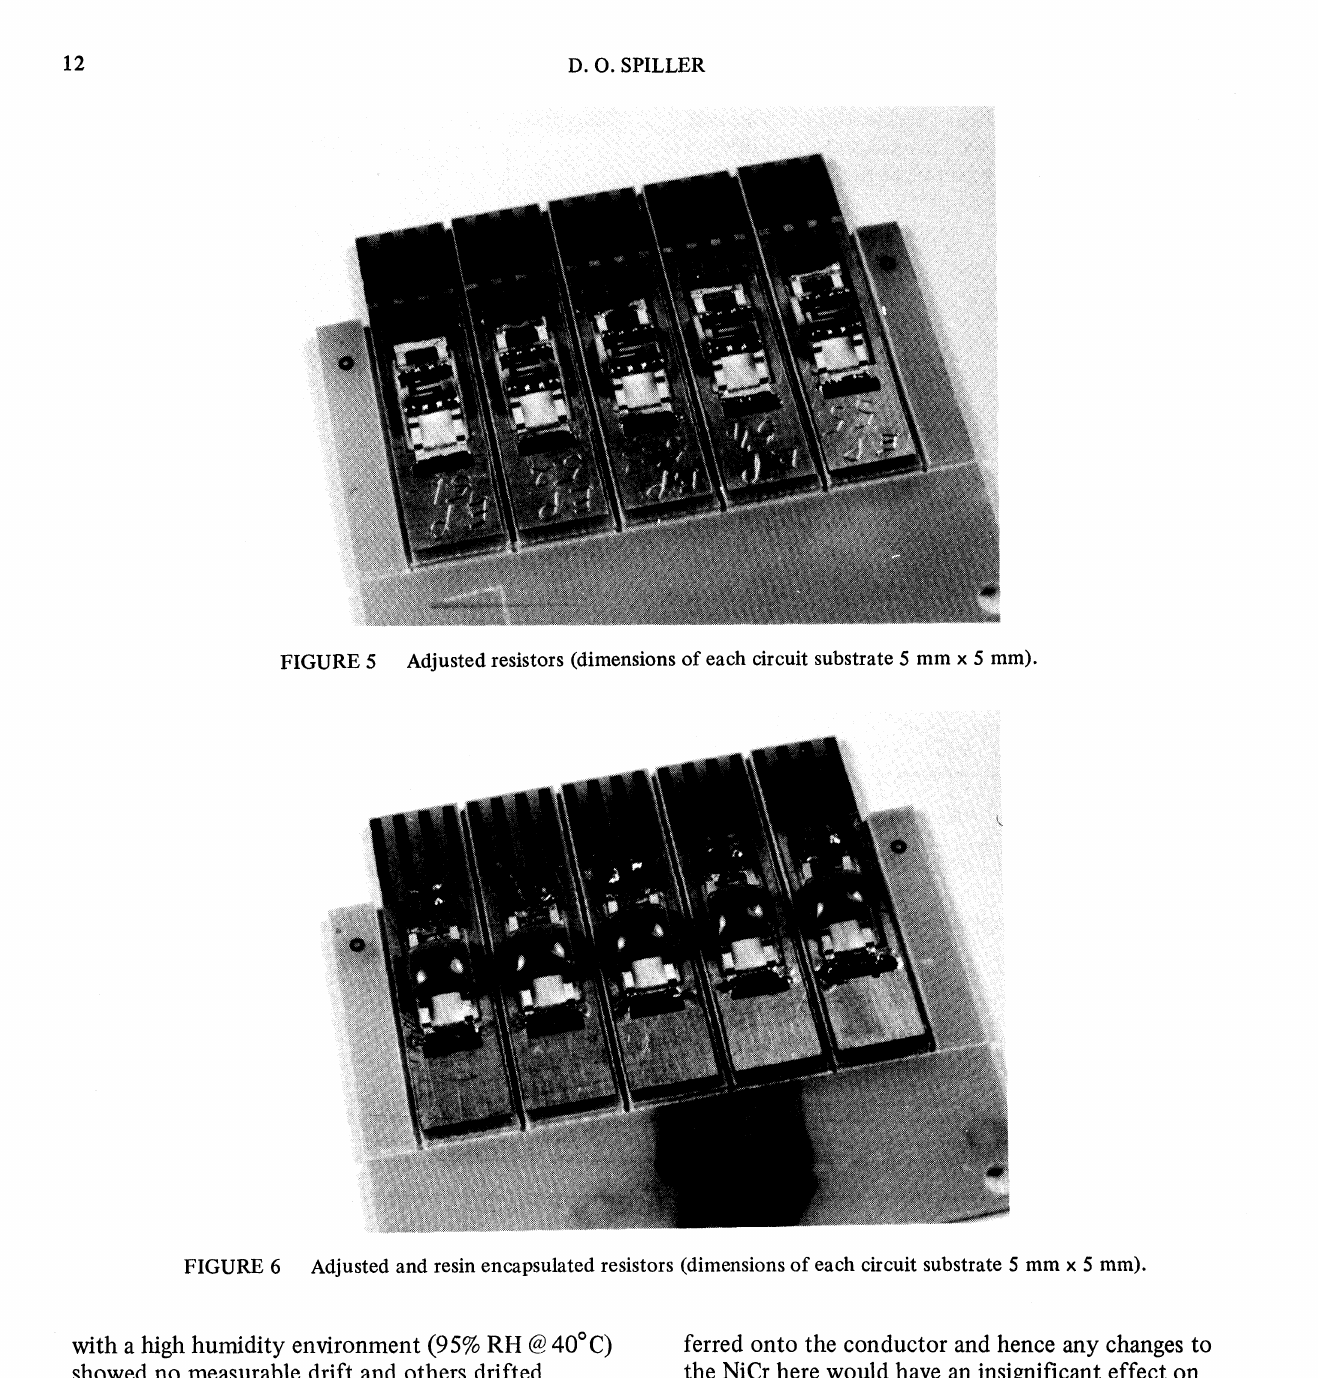
FIGURE 6 Adjusted and resin encapsulated resistors (dimensions of each circuit substrate 5 mm x 5